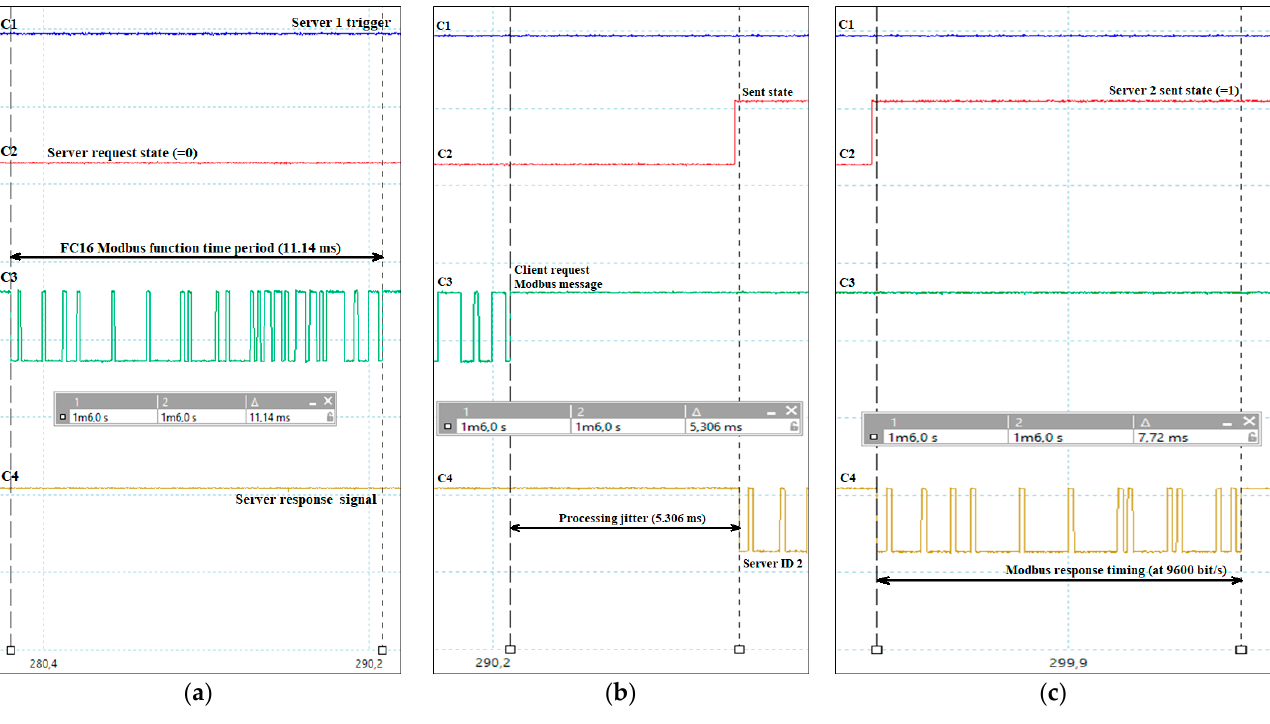
Figure 6. FC16 function experimental validation: ( a ) period of server 0x02 request message and FC16; ( b ) server processing jitter with FC16; ( c ) response message period of server with ID 0x02 and